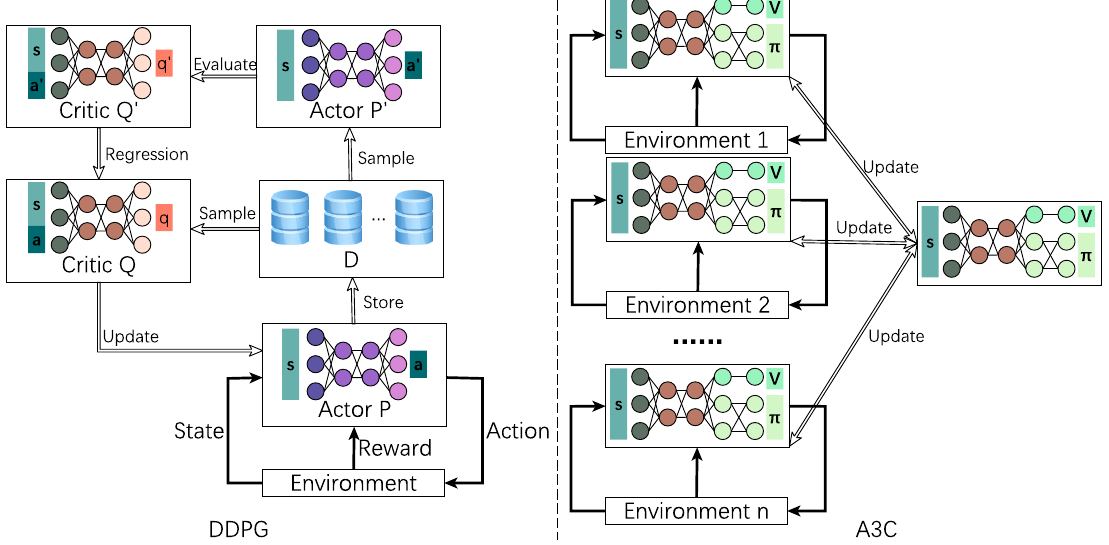
Figure 6. Deep Deterministic Policy Gradient (DDPG) and Asynchronous Advantage Actor-Critic